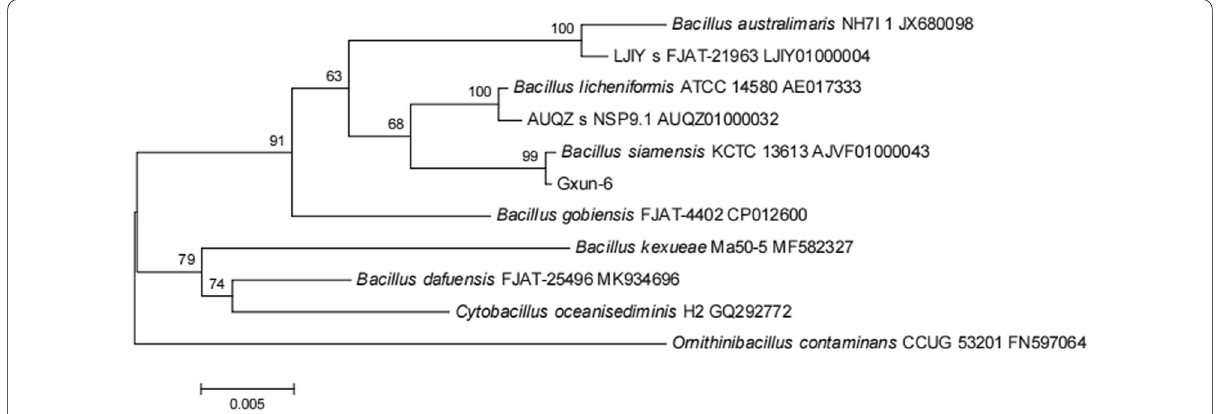
Fig. 4 Phylogenetic tree of strain Gxun-6